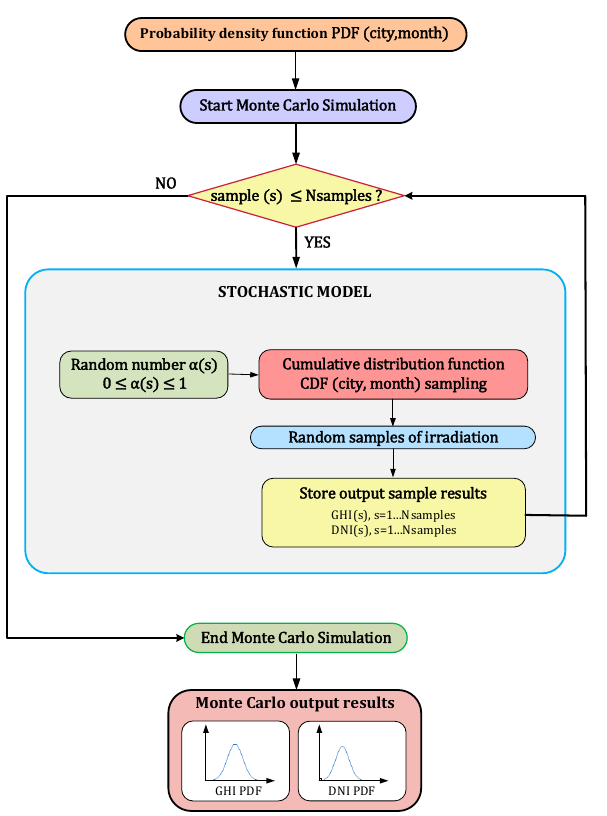
Figure 13. Basic structure of the Monte Carlo simulation algorithm for testing the PDFs. Source: own elaboration.